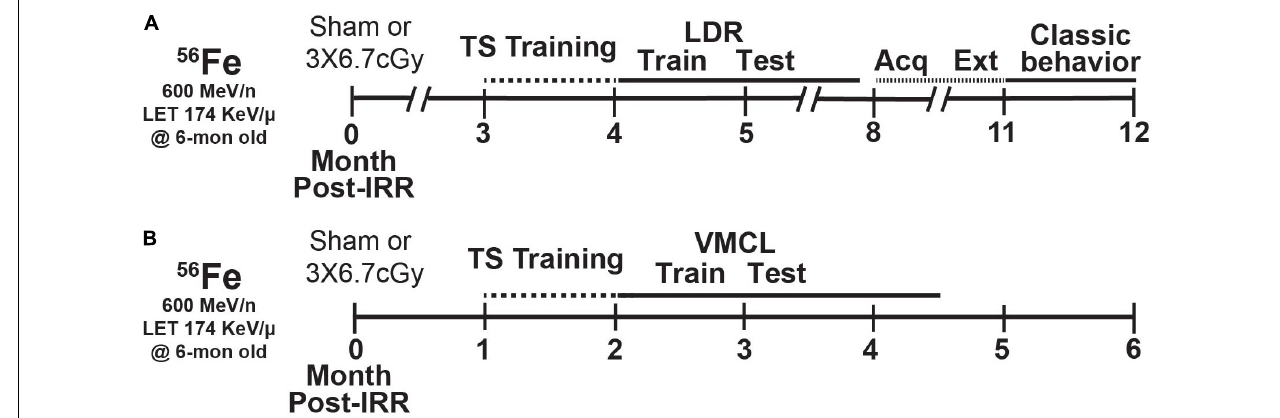
FIGURE 1 | Timeline of experimental groups and overview of behavior tests. Six-month-old C57BL/6J female mice received whole-body exposure to 56 Fe [0-Month (Mon) Post-Irradiation (IRR)] and subsequently were run on a variety of touchscreen and non-touchscreen behavioral tests, including (A) touchscreen training with a twelve-window (2 × 6) grid followed by LDR Train and Test, Acquisition and Extinction of stimulus-response habit learning, and classic behavior tests (EPM, MB, OF, SI, and FST) or (B) touchscreen training on a 3-window (1 × 3) grid followed by VMCL Train and Test. Acq, acquisition; Ext, extinction; LDR, location discrimination reversal; Test, testing; Train, training; TS, touchscreen; VMCL, visuomotor conditioning